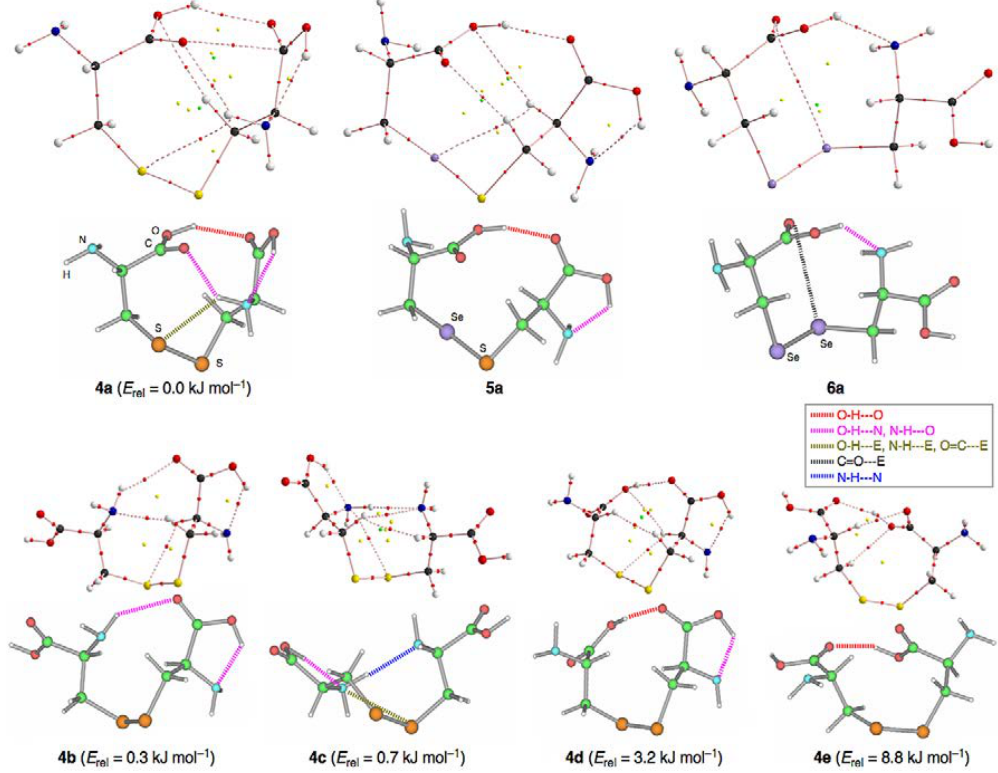
Figure 5. Molecular graphs of 4a – 6a , drawn on the optimized structures and the intramolecular non-covalent interactions, corresponding to BPs in the molecular graphs, drawn on the optimized structures (top two). Molecular graphs of 4b – 4e , drawn on the optimized structures and the intramolecular non-covalent interactions, corresponding to BPs in the molecular graphs, drawn on the optimized structures (bottom two).